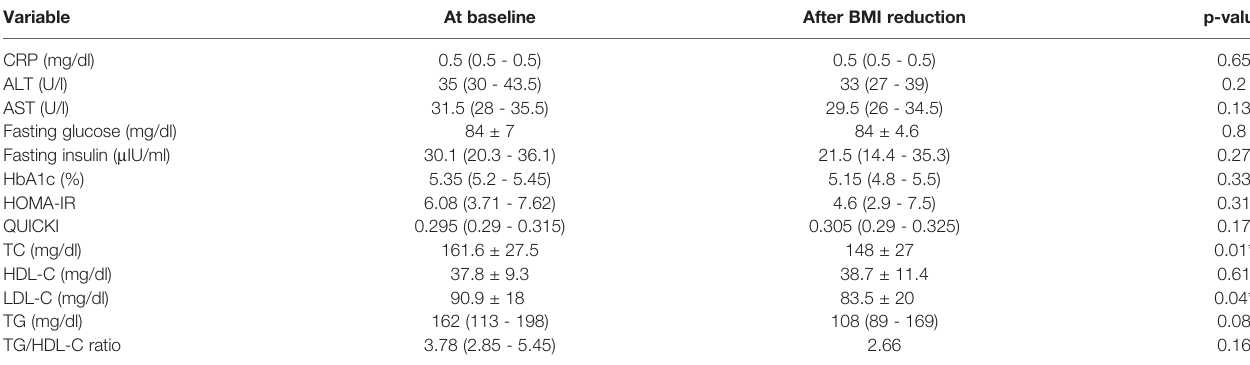
TABLE 4 | Comparison of biochemical parameters in subgroup of overweight/obese children at baseline and after BMI reduction (n=12). Variable At baseline After BMI reduction p-value CRP